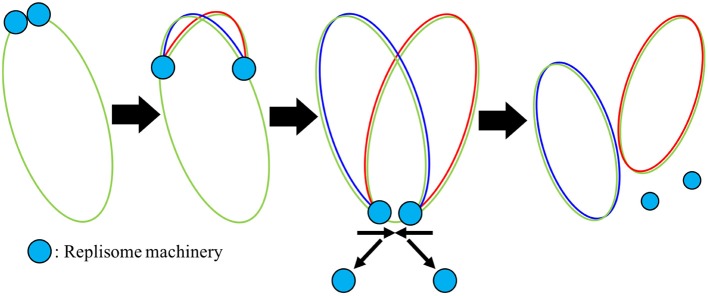
Mechanism of DNA replication: Once the replisome machinery is loaded onto the chromosome shown in green, the machinery begins to polymerize around the DNA, elongating new DNA onto both halves of the original chromosome shown in red and blue. Once the replisome reaches the terminus, we assume that the replisomes fall off quickly.